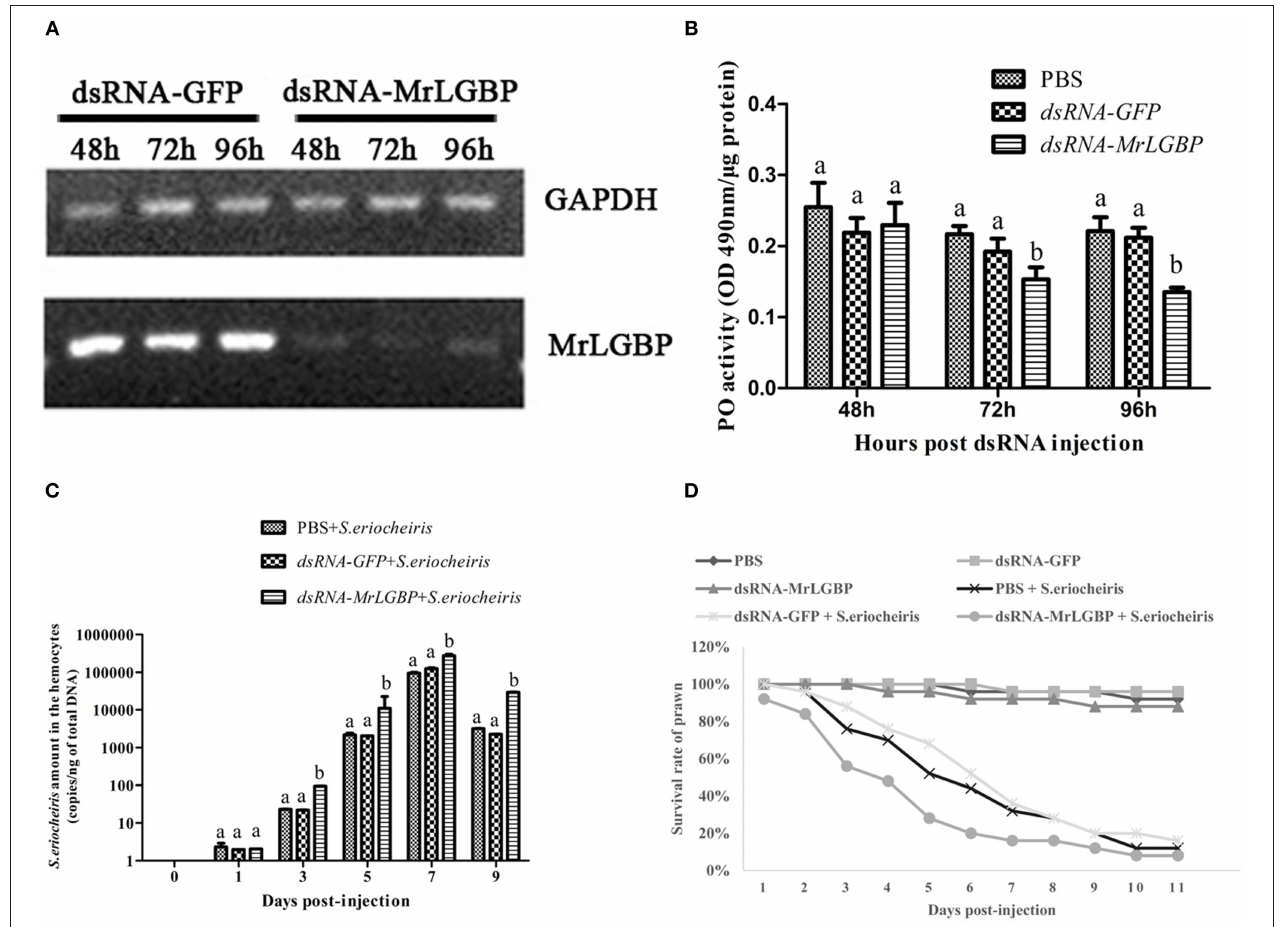
FIGURE 7 | MrLGBP silencing reduced the ability of M. rosenbergii resistance to S. eriocheiris . (A) Efficiency of MrLGBP silencing in hemocytes, as detected by semi-quantitative PCR. (B) The phenol oxidase (PO) activity in hemocytes was determined after MrLGBP silencing. Differences between each group were analyzed using one-way ANOVA. Different letters indicate statistical significance ( p < 0.05) and the same letter indicate no statistical difference ( p > 0.05). (C) The quantification of S. eriocheiris copies in hemocytes from the three groups detected by real-time PCR at 1, 3, 5, 7, and 9 days, respectively. Statistical significance was determined by Student’s t -test. Different letters indicate statistical significance ( p < 0.05) and the same letter indicate no statistical difference ( p > 0.05). (D) The survival rate of MrLGBP silencing prawn infected with S. eriocheiris . Prawn were divided six groups (50 prawn in each group). The prawns of the dsRNA-LGBP group and dsRNA-LGBP + S. eriocheiris group were injected with MrLGBP dsRNA. The prawns of the dsRNA-GFP group and the dsRNA-GFP + S. eriocheiris group were injected with GFP dsRNA. The prawns of the PBS group and PBS + S. eriocheiris group were injected with PBS. After 24h, the prawns were injected again with the same amount dsRNA or PBS. Forty-eight hours after the first injection, the prawns of the PBS + S. eriocheiris group, dsRNA-GFP + S. eriocheiris group, and dsRNA-LGBP + S. eriocheiris group received an injection of S. eriocheiris . The cumulative mortality of prawns was recorded